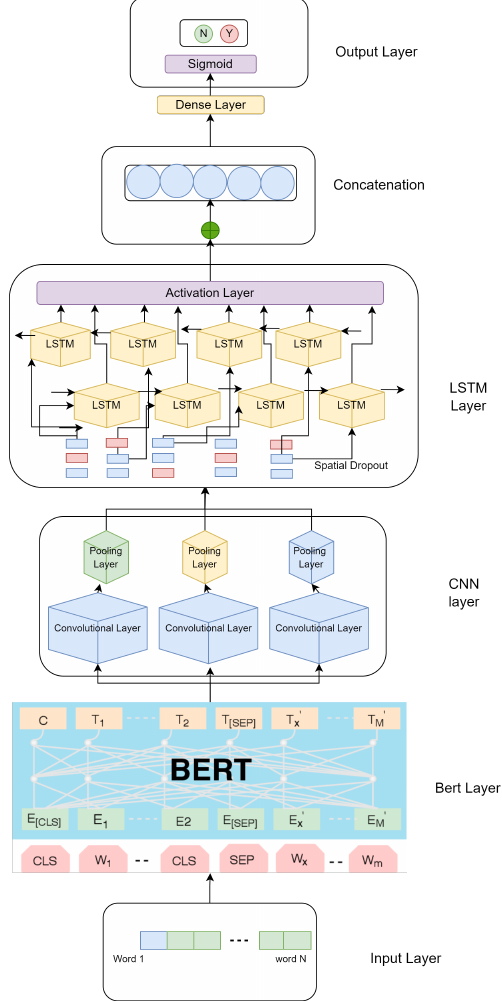
Figure 1. Representative mechanism of Bangla-BERT to CNN-BiLSTM in sentiment analysis. First, BERT accepts tokens for embedding, and then passes through the CNN layer for the extract infor- mation. Next, LSTM aids to create a sequence from the extracted information after FNN makes a decision by calculating